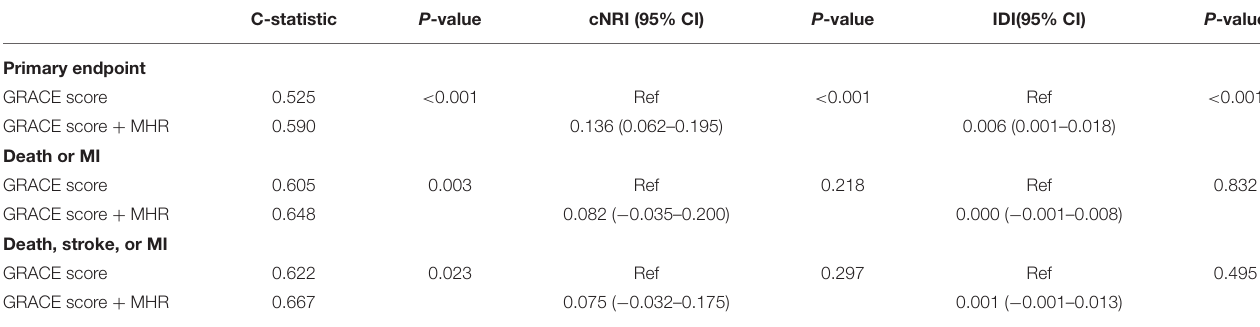
TABLE 4 | Model performance after the addition of MHR to the GRACE risk score for predicting clinical outcomes. C-statistic P -value cNRI (95% CI) P